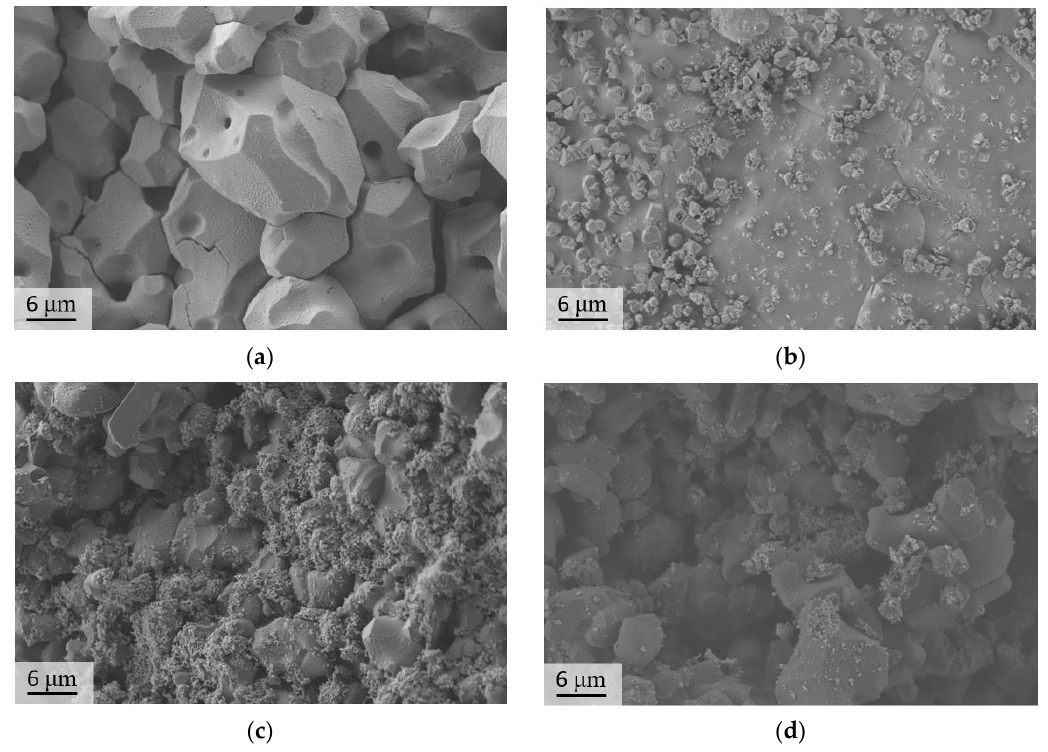
Figure 10. SEM images (SE2) of the fractured samples: ( a ) Mg20K, ( b ) Mg10K, ( c ) Mg20KY-TZP, and ( d ) Mg10KY-TZP.